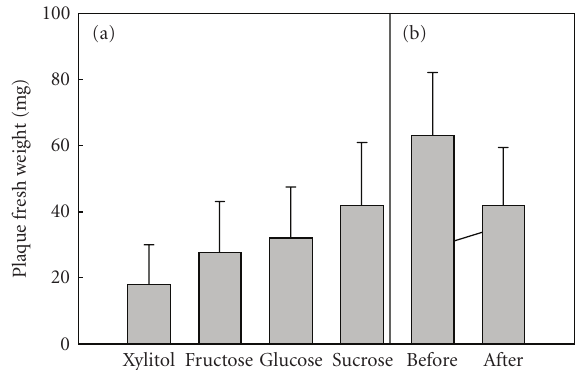
Figure 1: “How it all began”: a pioneering plaque assessment study carried out in 1970 (a). E ff ect of dietary carbohydrates and xylitol on the growth of dental plaque after consumption of the shown sweeteners for four days (while the subjects refrained from oral hygiene), mainly in co ff ee or tea, and in the form of hard candies [11]. The consumption level of each sweetener was about 20g per day and per subject. The values shown are means ± S.D. of fresh weight of plaque collected from all available tooth surfaces. (b) Inverse relationship between plaque fresh weight and its protein content. Twelve test subjects used xylitol chewing gum five times a day over a period of one month. Plaque from all available surfaces was collected following a 2-day no-oral-hygiene period. Consumption level of xylitol per day and per subject was 6.7g. Xylitol consumption was associated with reduced plaque mass while the protein content of plaque simultaneously rose from 1.1 ± 0.2mg to 1.4 ± 0.2 mg per mL of plaque suspension (straight line). Protein and nitrogen analyses should not be claimed to accurately determine the amount of dental plaque in clinical studies involving sugar